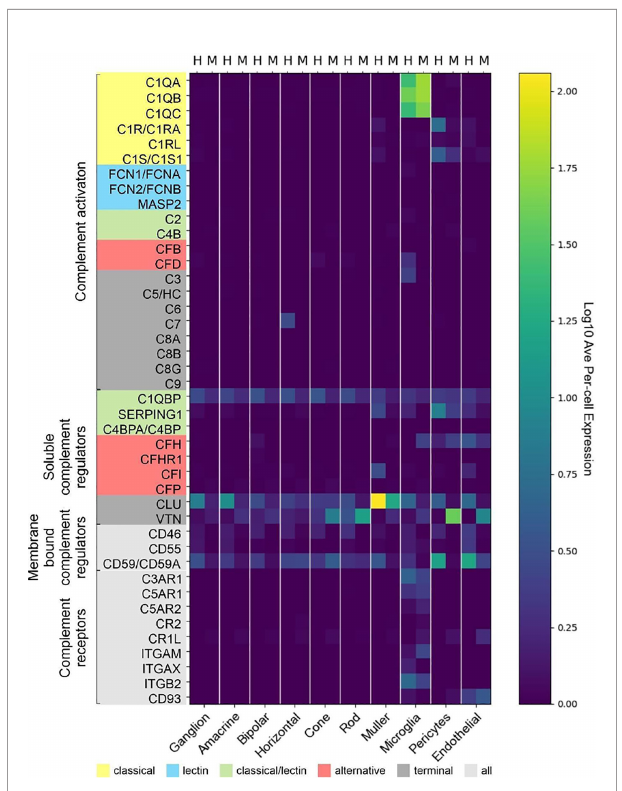
FIGURE 7 | Comparison of cell type-speci fi c complement expression between peripheral human (H) and mouse (M) retina. Expression of complement components was determined by scRNA-seq. For cross-species comparison data from the present study on human retina was compared to recently published data from mouse retina (48). Expression is measured in units of FPKM (Fragments Per Kilobase of transcript per Million mapped reads) and color-coded on a logarithmic